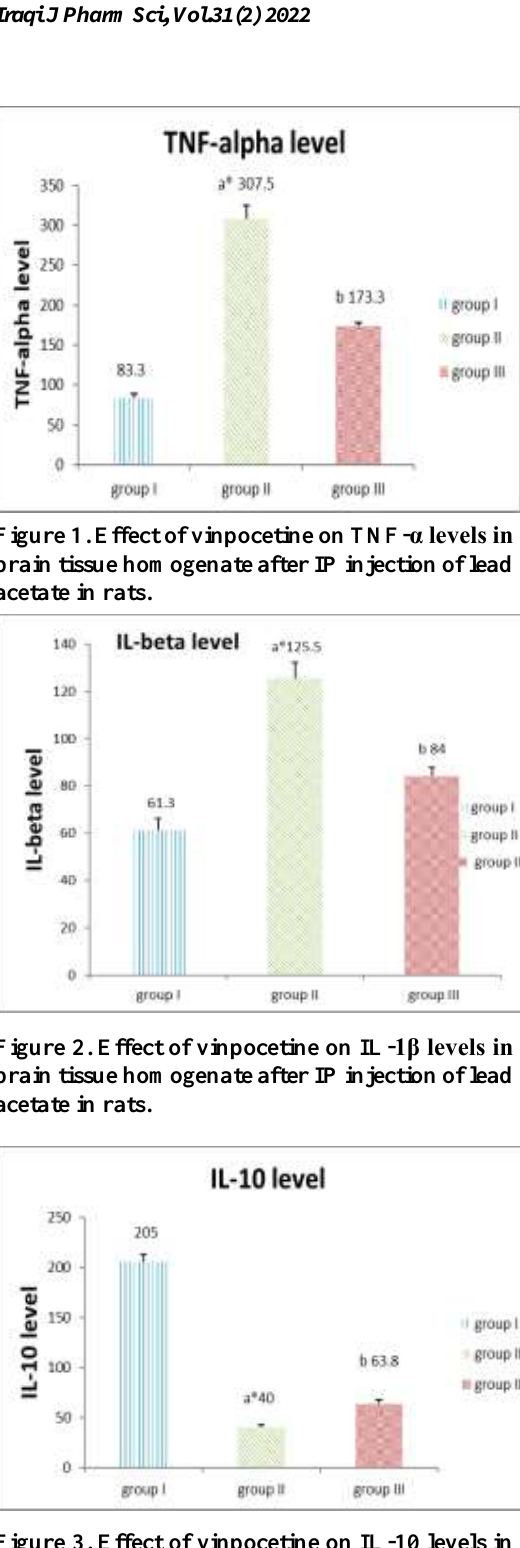
Figure 3. Effect of vinpocetine on IL-10 levels in brain tissue homogenate after IP injection of lead acetate in